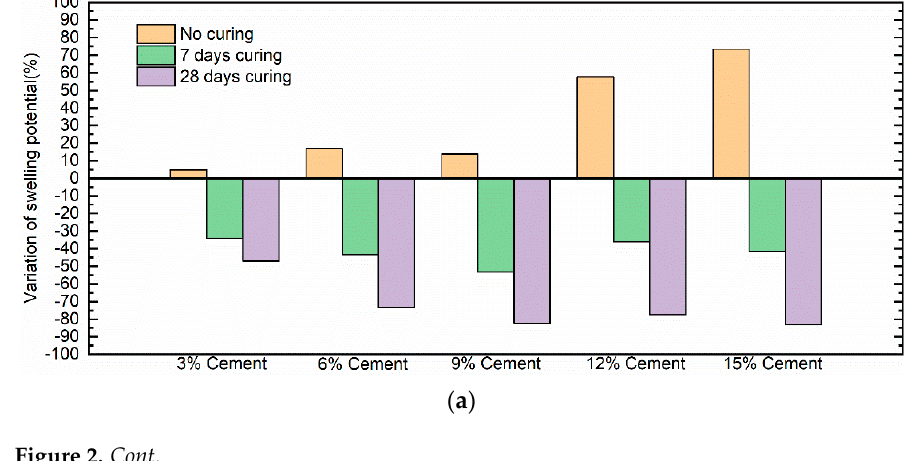
Figure 1. The specimen in the stainless steel ring ( left ) and schematic of the test setup used for the no loading swelling ratio test ( right